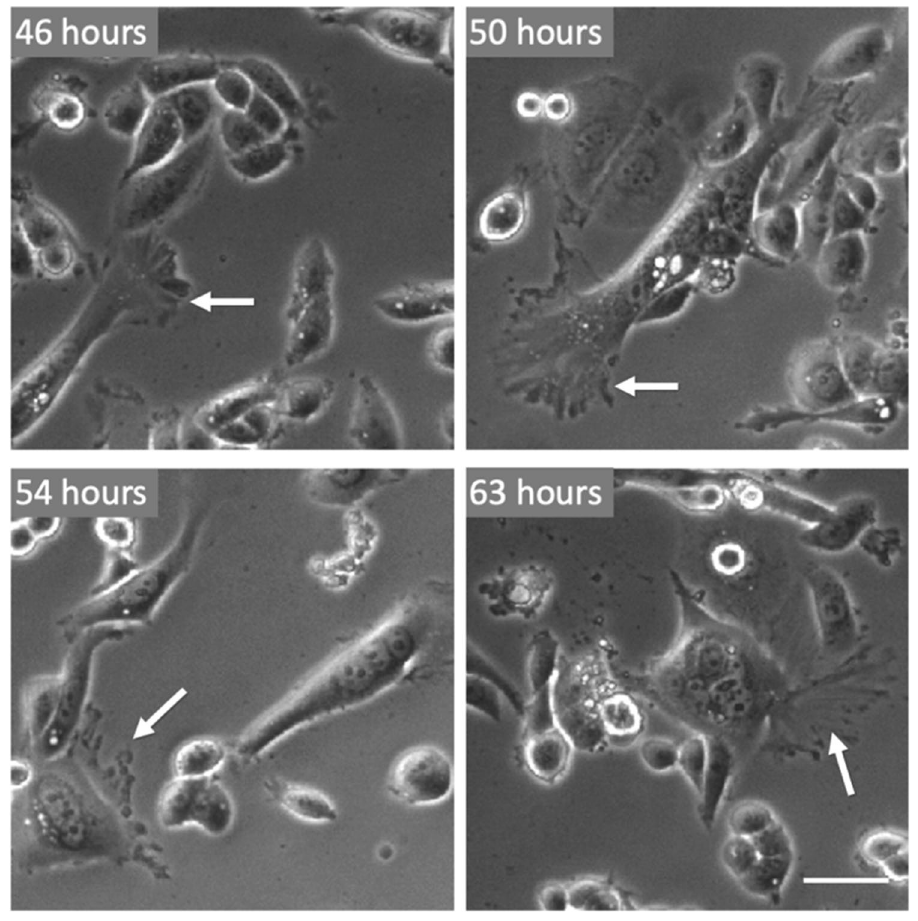
Figure 5. Four examples for the typical phenotype of the small multinucleated MDA-MB-468 cells. The fused cells develop large lamellipodia and filopodia (white arrows) that change continuously over time. Scale bar represents 10